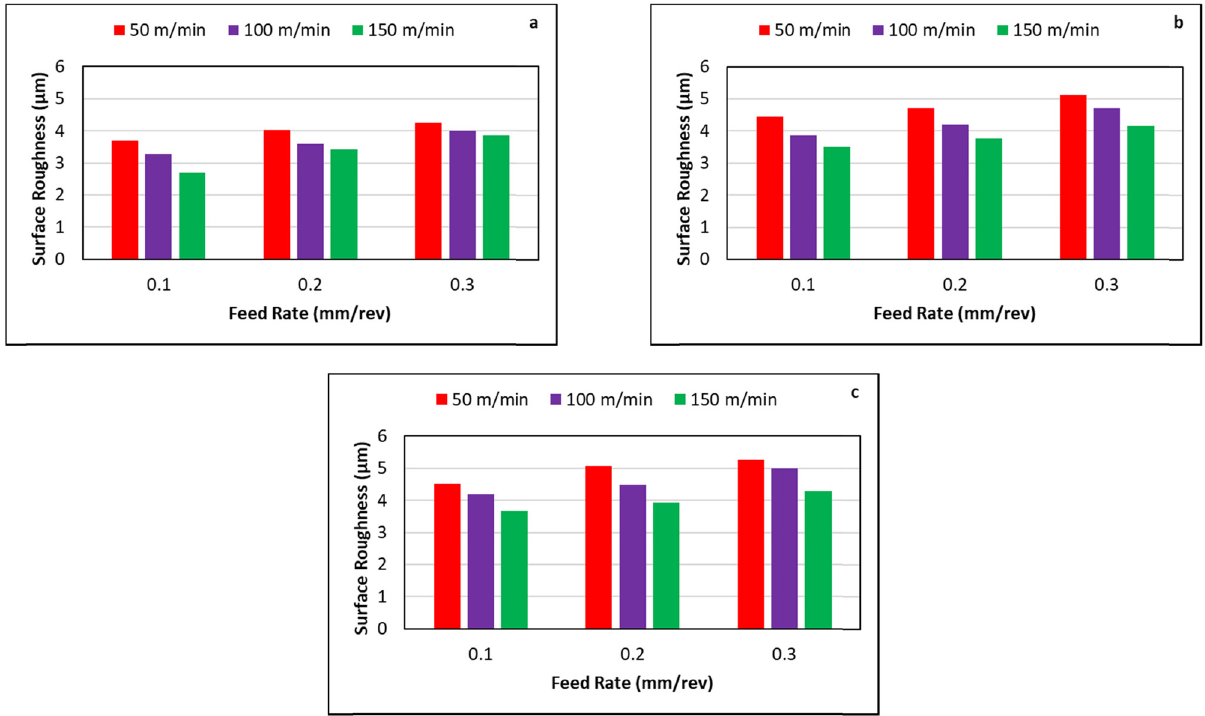
Figure 10: In fl uence of feed rate on surface roughness at constant depth of cut 2 mm: ( a ) fi ber orientation 30°, ( b ) fi ber orientation 60°, and ( c ) fi ber orientation 90°.